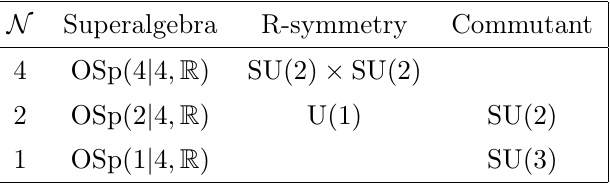
Table 1. Three-dimensional N = 1 ; 2 ; 4 superconformal algebras that are subalgebras of PSU(2 ; 2 j 4) . These are the possible symmetry algebras of the superconformal interfaces in N = 4 SYM studied in [4]. A subalgebra of the commutant algebra realizes the flavor symmetry of the